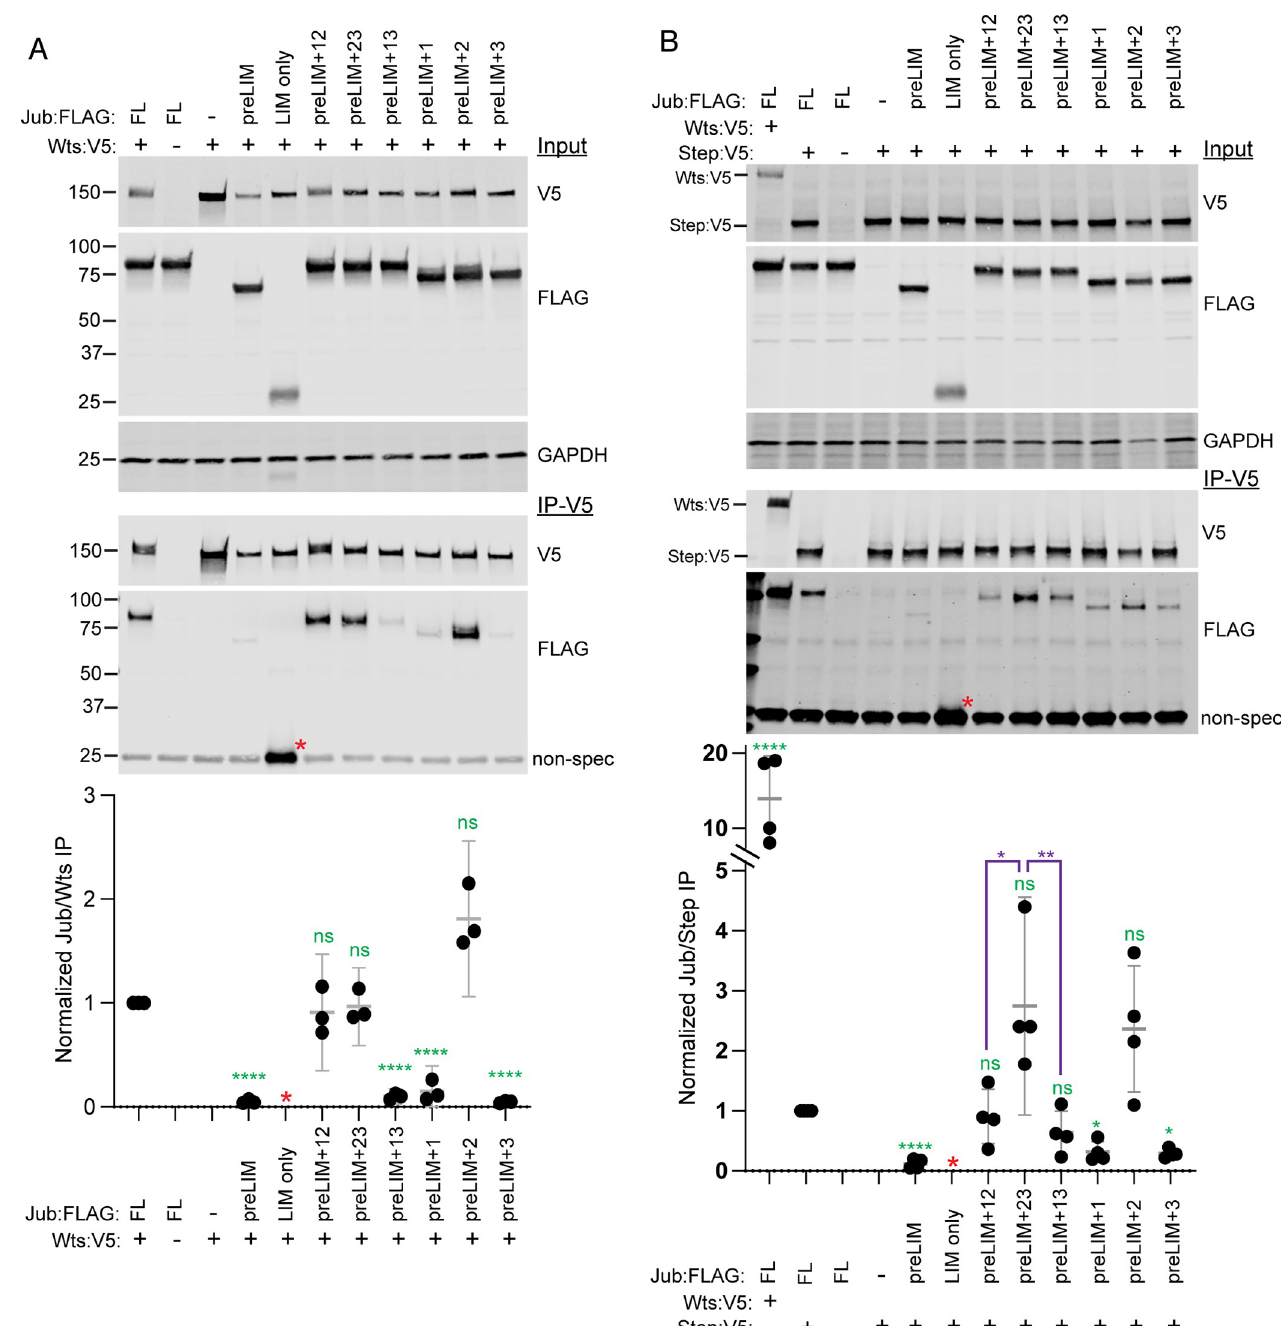
Fig 5. Association of Jub with Wts and Step. A) Results of co-immunoprecipitation experiments between FLAG-tagged Jub constructs and V5-tagged Wts. Top three gels show western blots of cell lysates transfected to express the indicated proteins, using antibodies indicated at right. Bottom two gels show western blots on material precipitated with anti-V5 beads. In the lower blot, Jub:FLAG construct bands are at top and a non-specific band is at bottom, except for LIM only (red asterisk), which overlaps the non-specific band. Scatter plot at bottom shows quantitation of relative Jub/Wts band intensity in immunoprecipitates, normalized to the results for full length Jub, from three biological replicates, with mean and 95% ci indicated by gray bars. Statistical comparisons (ANOVA) to the values for full length Jub are indicated in green. Quantitation of the LIM only band is not included because the signal cannot be separated from the background band. B) Results of co-immunoprecipitation experiments between FLAG-tagged Jub constructs and V5-tagged Step, with Wts:V5 also included for comparison of full length Jub binding. Top three gels show western blots of cell lysates transfected to express the indicated proteins, using antibodies indicated at right. Bottom two gels show western blots on material precipitated with anti-V5 beads. In the lower blot, Jub:FLAG construct bands are at top and a non- specific band is at bottom, except for LIM only (red asterisk), which overlaps the non-specific band. Scatter plot at bottom shows quantitation of relative